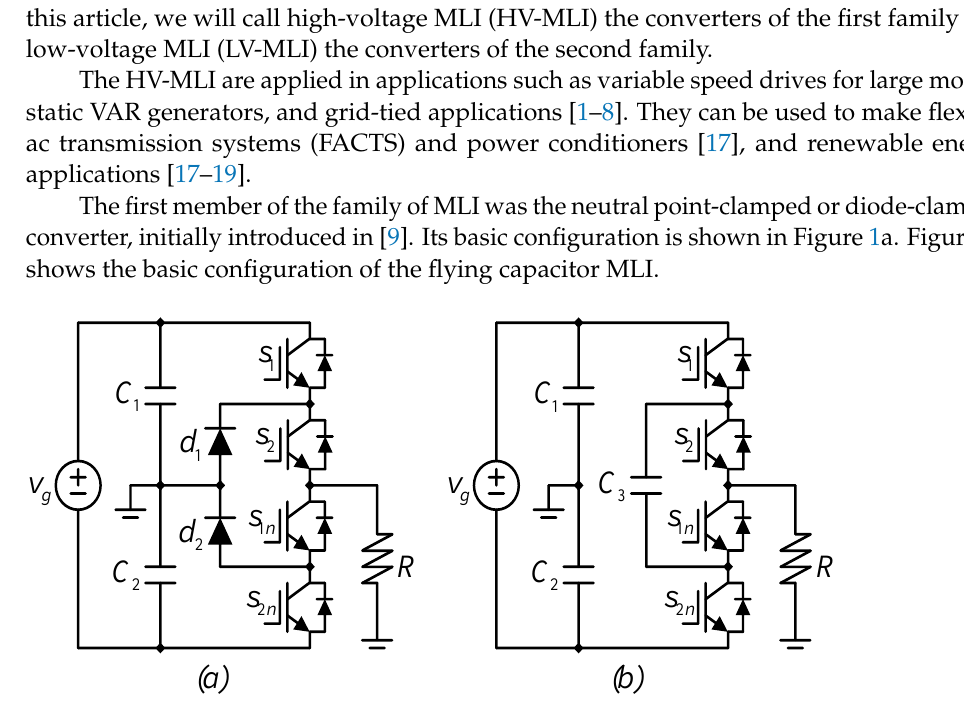
Figure 1. The two topologies of HV-MLI are ( a ) neutral point-clamped or diode-clamped and ( b ) flying capacitor or capacitor-clamped MLI.